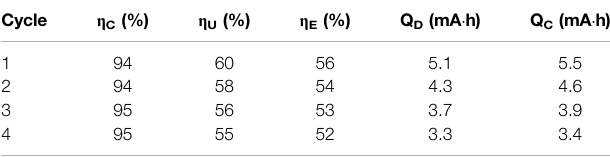
TABLE 3 | Microemulsion RFB metrics.